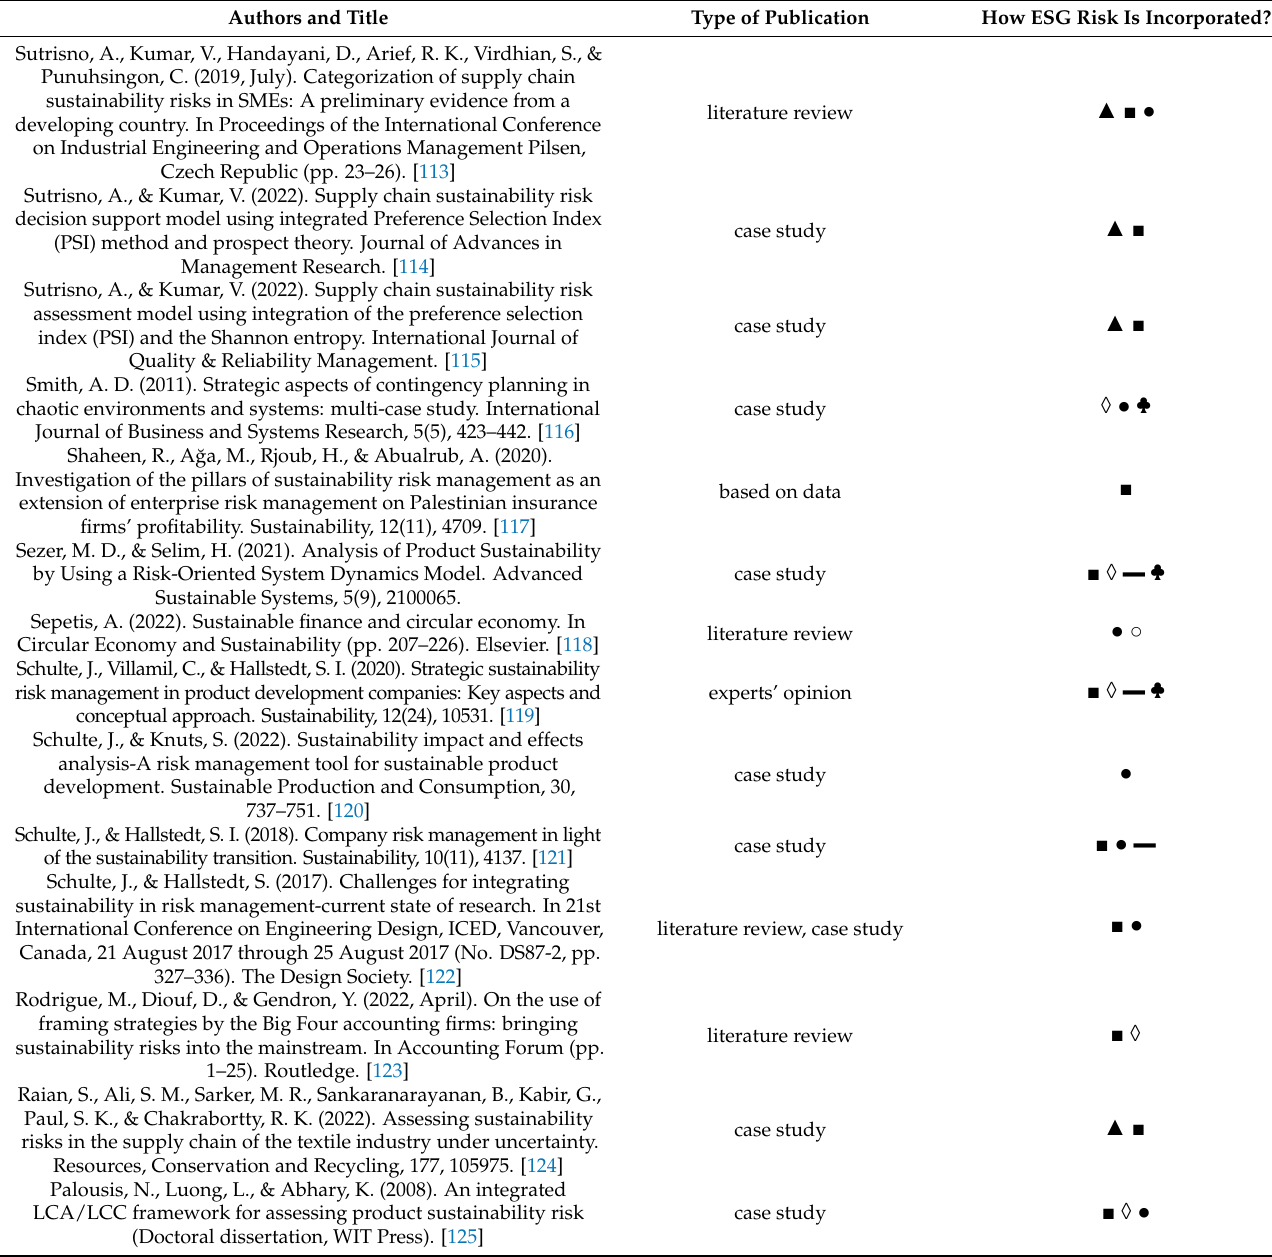
Symbols meaning: ▲ Circular economy; ♣ Risk